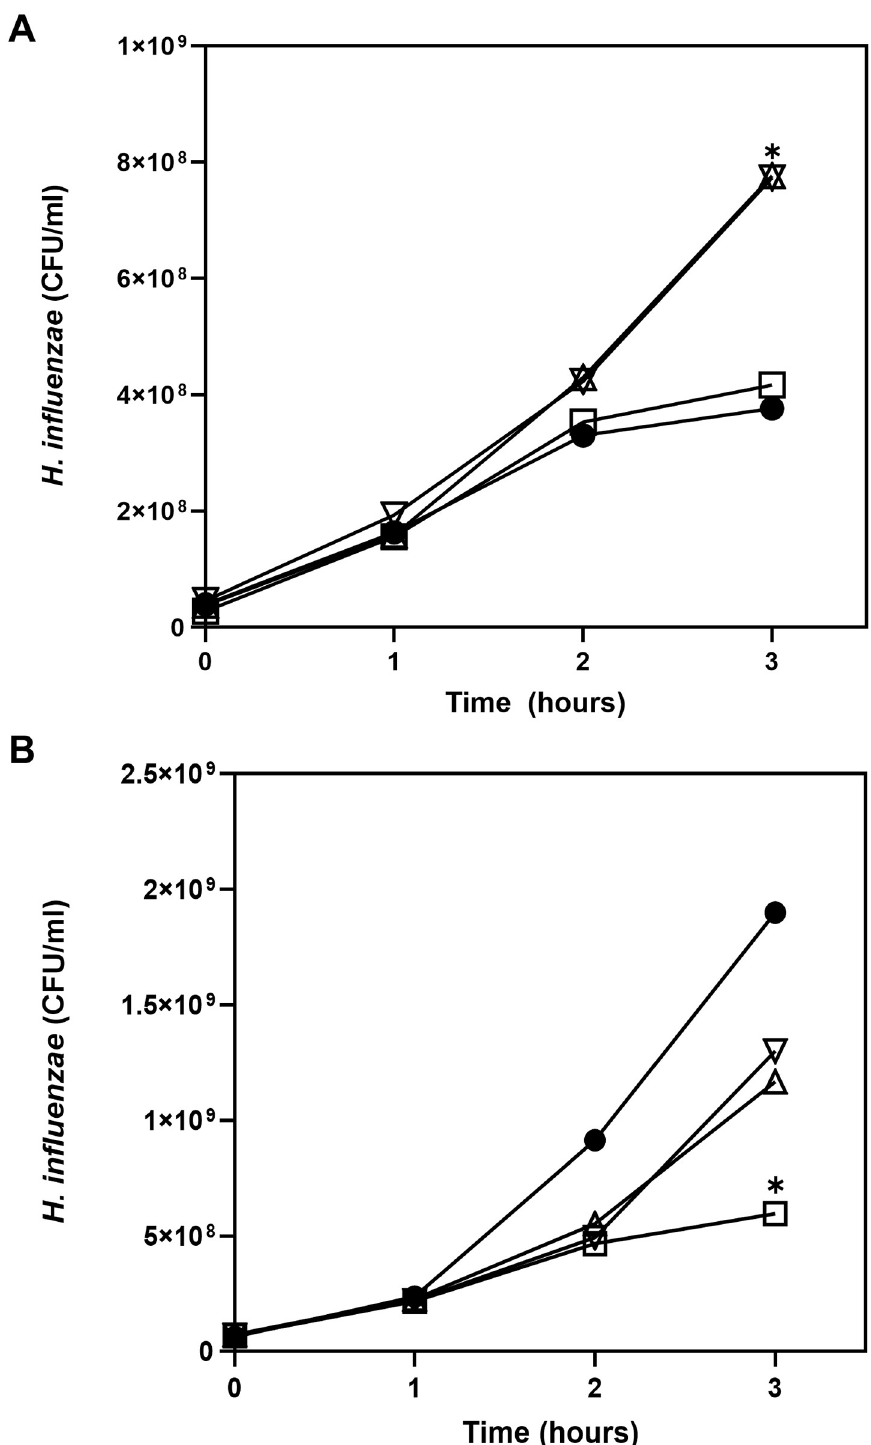
Fig 5. Effect of co-culture with GAS on growth of H . influenzae . A . Growth of H . influenzae alone ( ● ) in BHI with heme (NAD + -depleted condition), or with GAS wild type strain 854 ( □ ), 854 nga G330D ( Δ ), or 854 Δ nga ( 5 ). � P < 0.05, H . influenzae alone or with GAS 854 vs. H . influenzae with 854 nga G330D or 854 Δ nga . B . Growth of H . influenzae alone ( ● ) in sBHI (NAD + -replete condition) or with GAS 854 ( □ ) or isogenic mutants 854 nga G330D ( Δ ) or 854 Δ nga ( 5 ). � P < 0.05, H . influenzae with 854 vs. H . influenzae alone, and H . influenzae with 854 vs. H . influenzae with 854 nga G330D or 854 Δ nga . Data are the mean of three biological replicates.